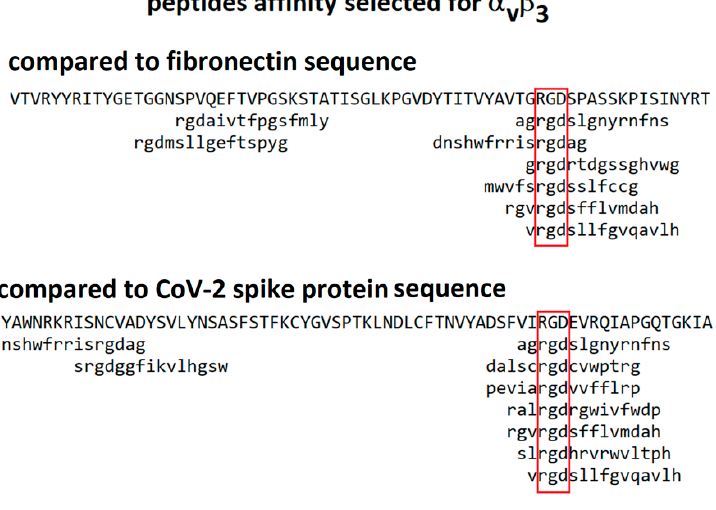
Figure 4. Alignment of peptides selected for affinity to integrin α v β 3 against the sequences of fibronectin and CoV-2 spike protein. The red boxes indicate position of the 'rgd' motif. The library screened was constructed of 15-mer linear peptides [27].